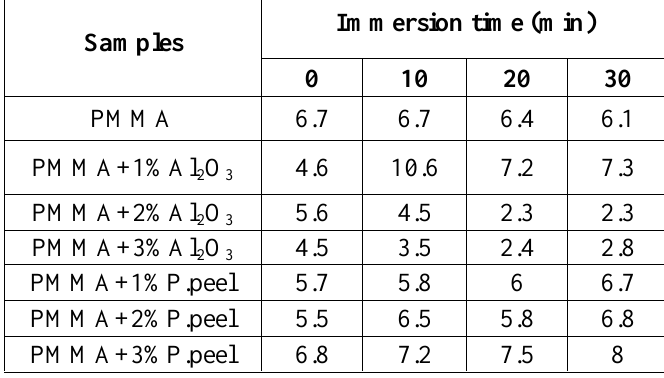
Table 3: Value of impact strength I.S. (kJ/m 2 ) for both nanocomposite PMMA + (1%, 2%, 3%) of Al O and peanuts peel respectively during immersion in 2 3